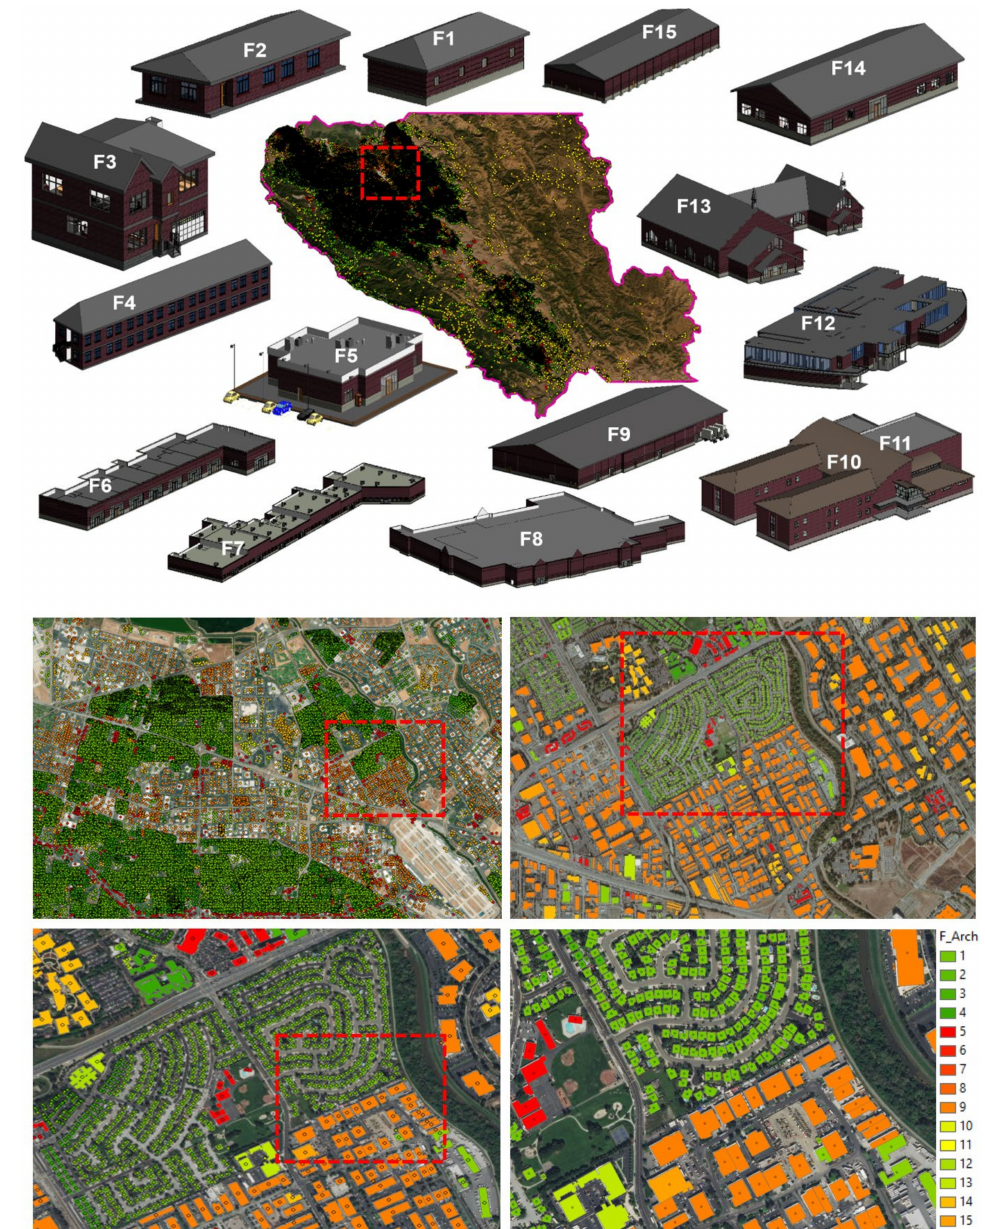
Figure 12. Schematic representation of the Santa Clara County color-coded based on the 15 building archetypes portfolio with close-up views on select